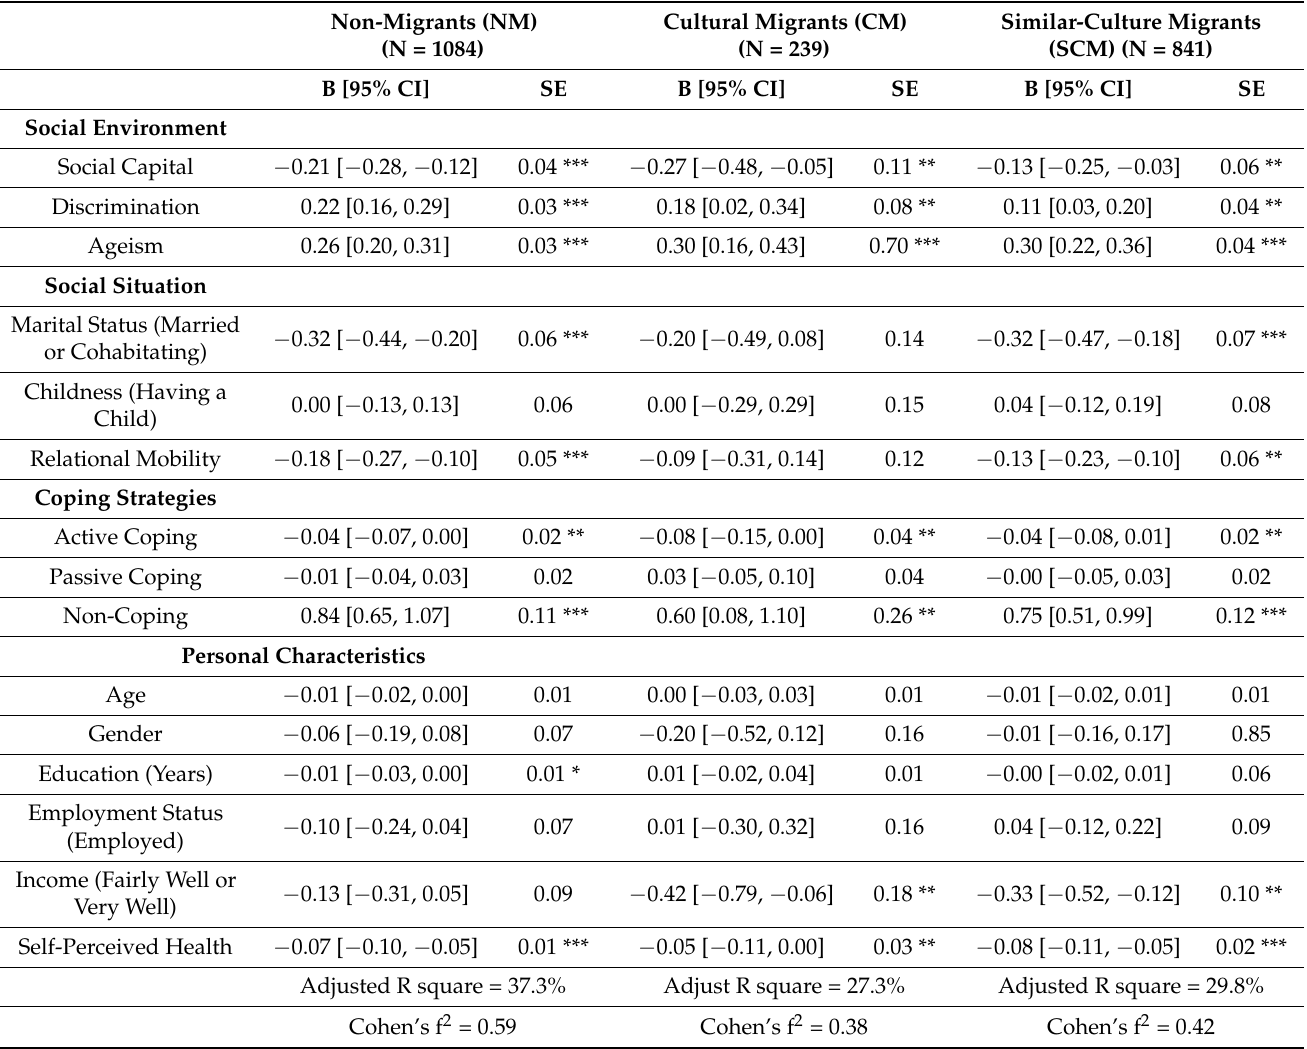
Table 2. Linear regressions stratified by culture of